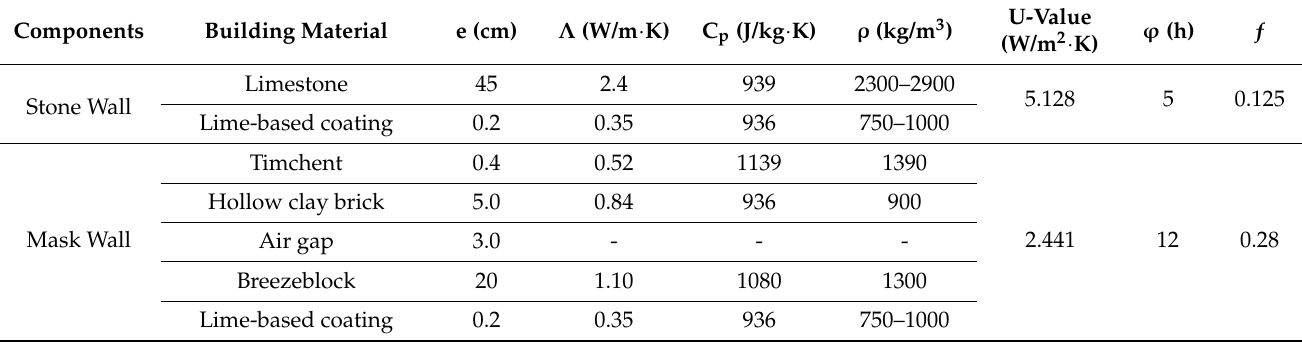
Table 3. Thermal properties of the building’s envelope components [50,51].